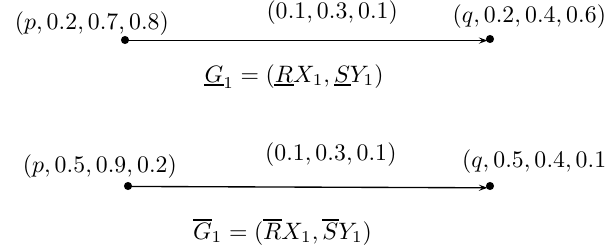
, G 1 ). 1 , G 1 ). 1 , G 1 ). 1